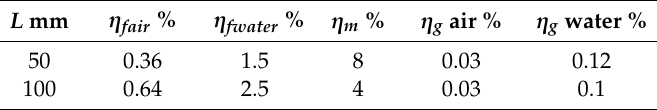
Table 10. Conversion e ffi